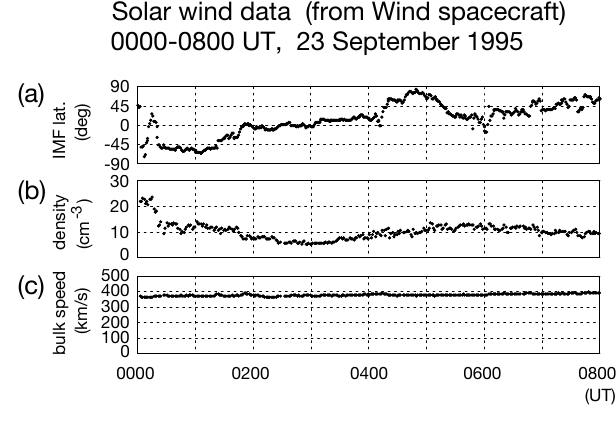
Fig. 5. Solar wind observations between 00:00–08:00 UT on 23 September 1995 in the same format as Fig.